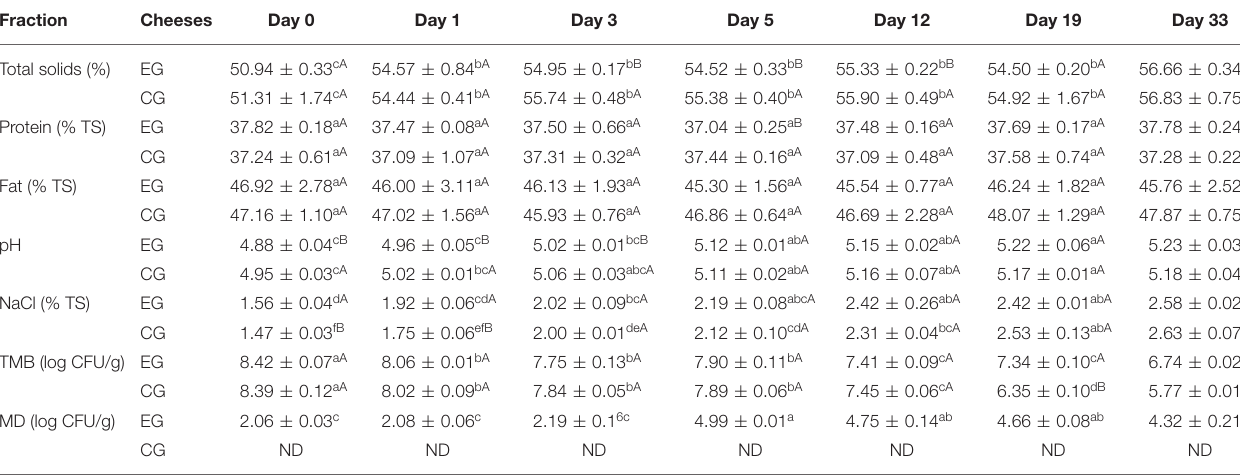
TABLE 1 | Changes in physicochemical and microbial parameters during cheese ripening. Fraction